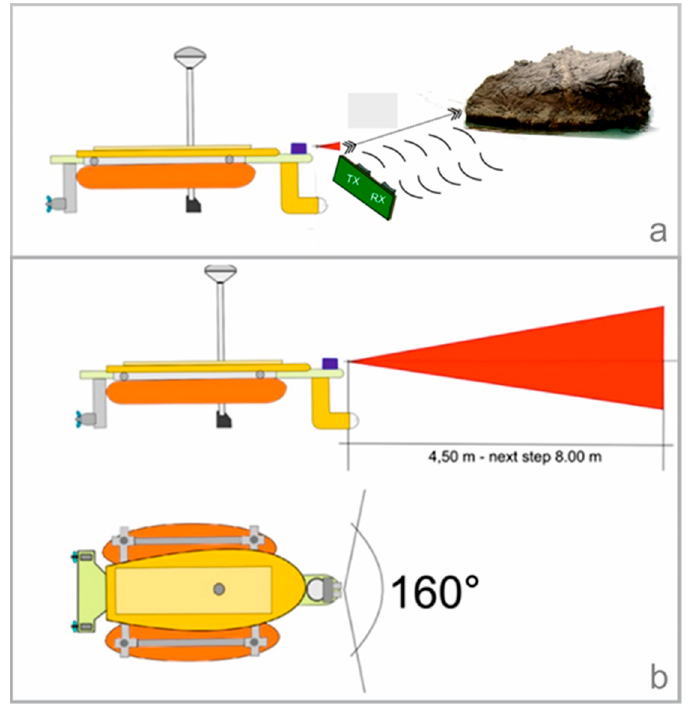
Figure 9. ( a ) Operation of the ultrasonic sensor; ( b ) Action range of obstacle-detection